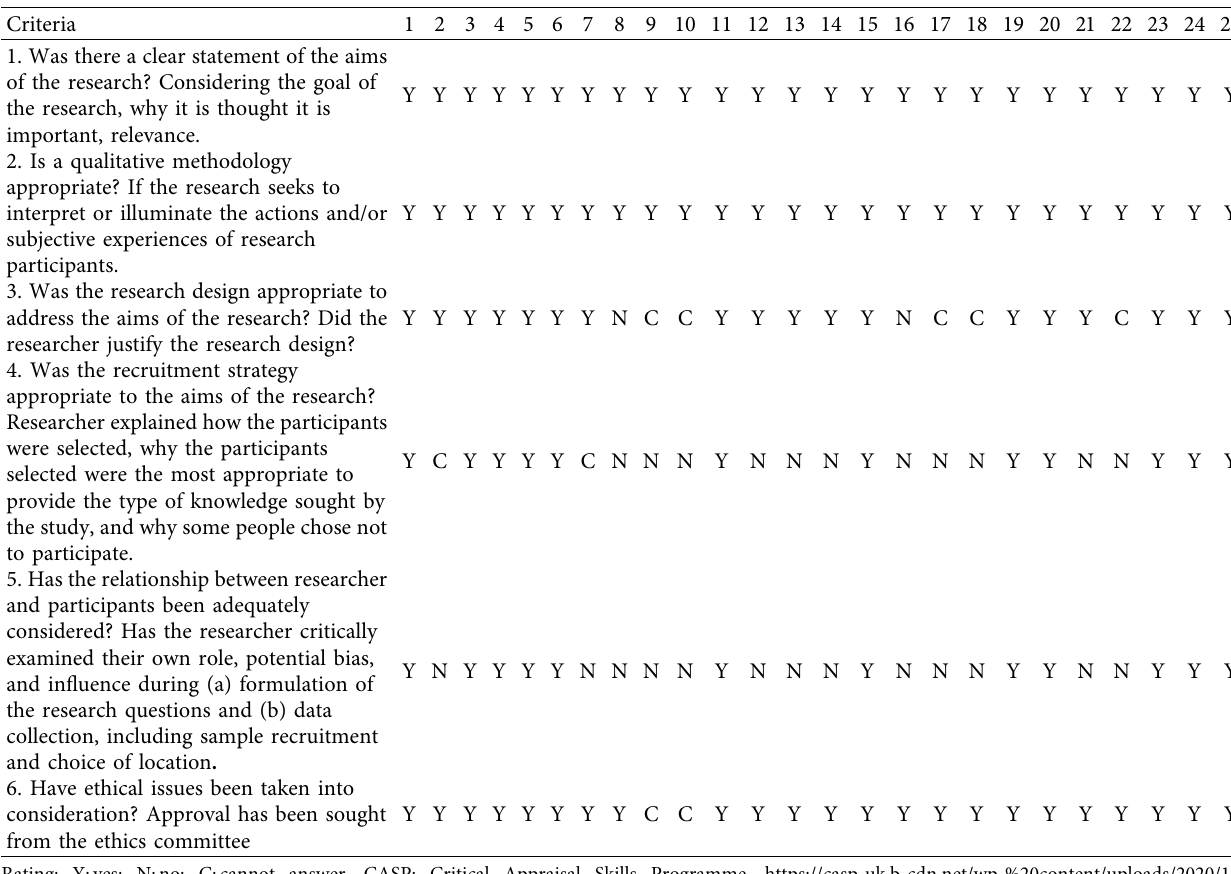
Table 2: Quality appraisal: CASP Qualitative Studies Checklist and evaluative criteria.